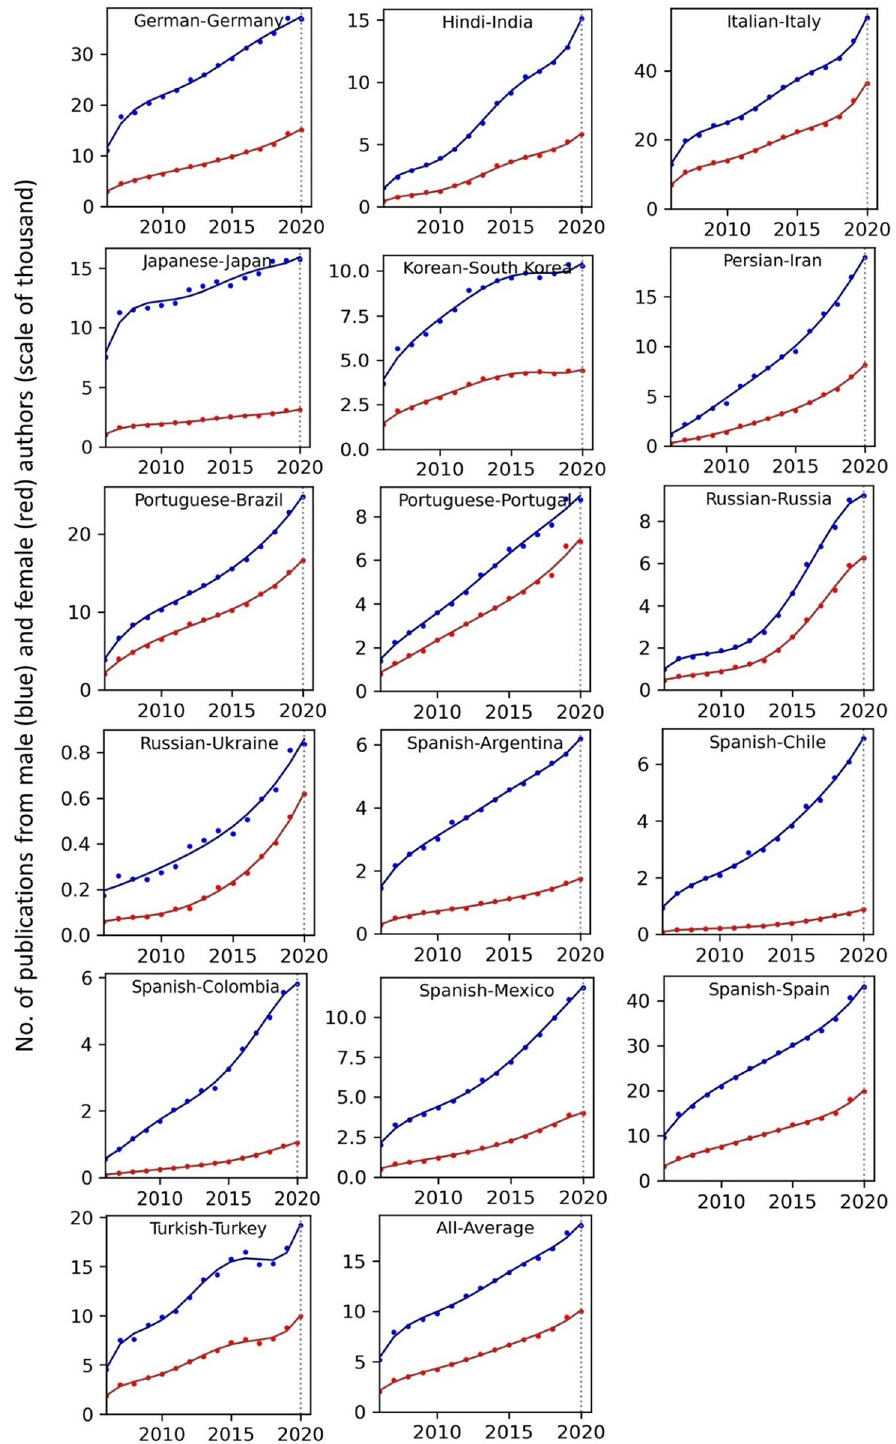
Fig 10. Temporal trends in male (blue lines) and female (red lines) total research productivity based on A-C method (part 2).